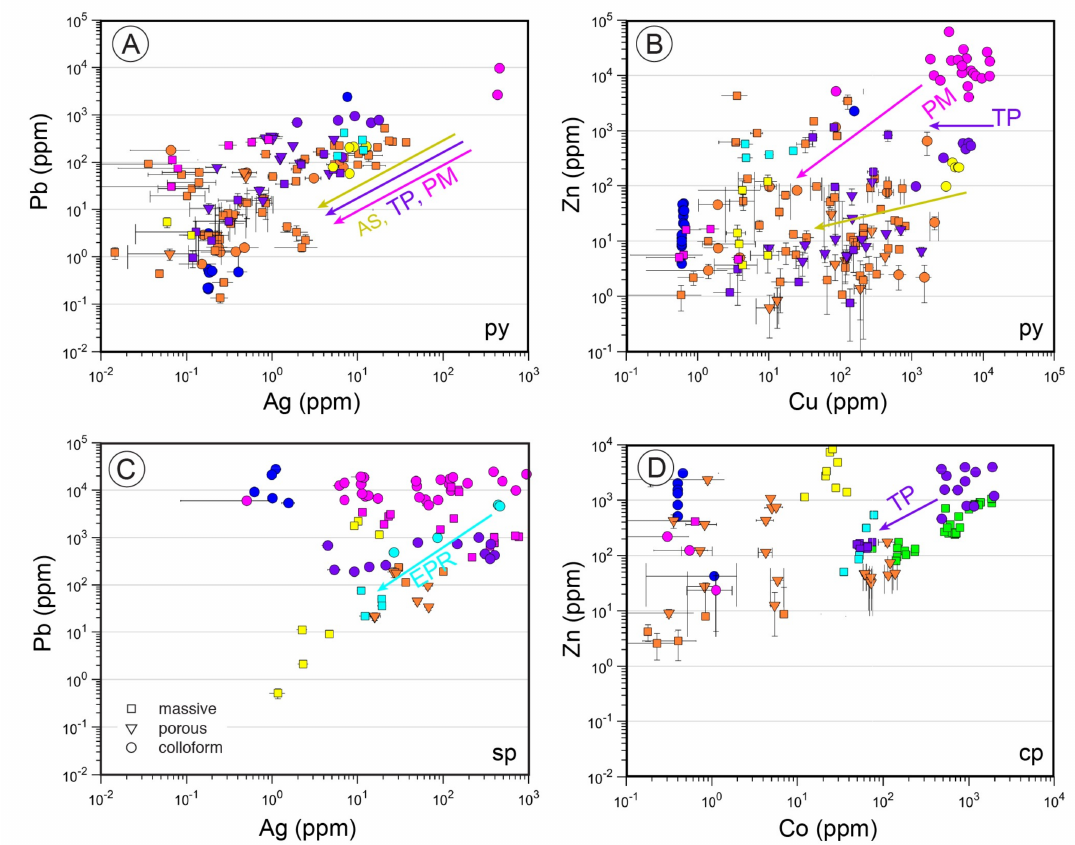
Figure 11. Trace element concentrations (Pb, Ag, Zn, Cu and Co) categorised by mineral type, sample suite (colour), and textures observed (shape). Logarithmic plots displaying the range of trace element concentrations (Pb, Ag, Zn, Cu and Co) for different textures (shape) of pyrite, chalcopyrite and sphalerite coloured by sample suite. Abbreviations for sample suite include AS ( Axial Seamount, yellow), TP ( Turtle Pits, purple), PM ( Pacmanus, magenta), EPR ( East Pacific Rise, cyan). ( A ) Pb versus Ag (pyrite); ( B ) Zn versus Cu (pyrite) ( C ) Pb versus Ag (sphalerite) ( D ) Zn versus Co (chalcopyrite). Coloured arrows highlight a change in texture from colloform to massive across one sample